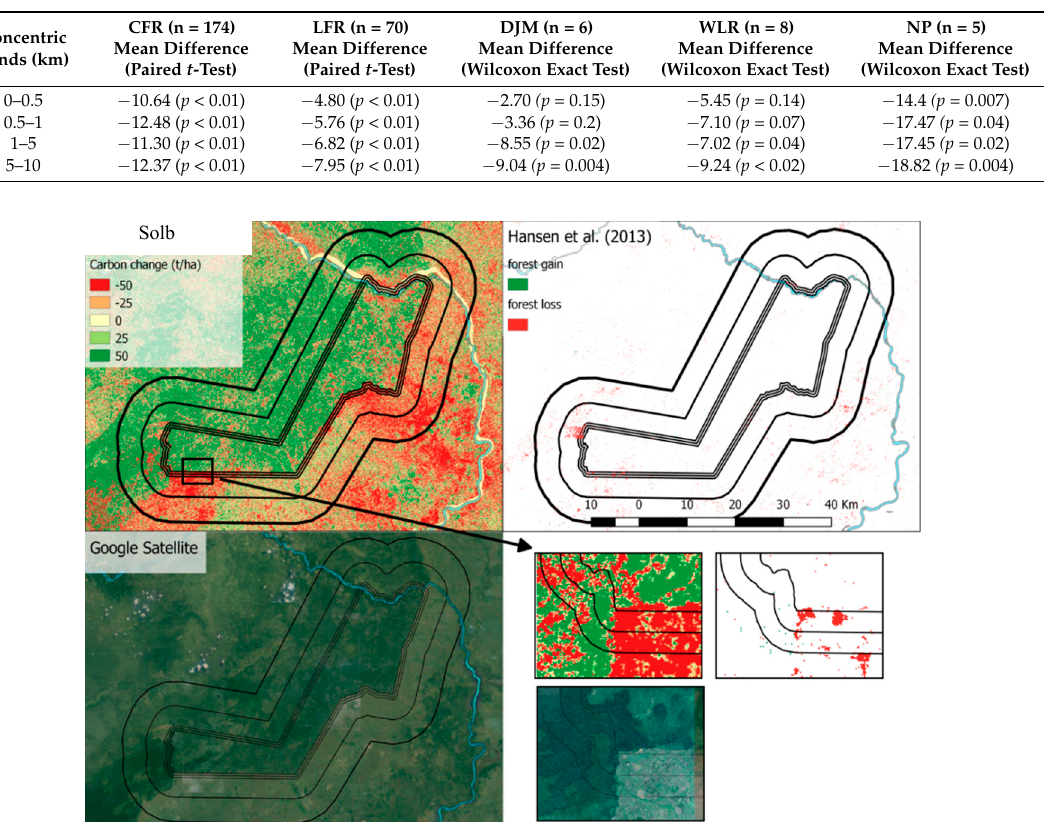
Figure 6. Leakage in “Effective” PA (Karuma WLR, area = 57,000 ha), upper left panel, demonstrating a sharp contrast in carbon change between inside PA (carbon gain) and external buffer zones (carbon loss). Additional figures are for visual comparison, extracts of Google Earth images and Global Forest watch, and forest cover change for the same period (2000–2012) [34].